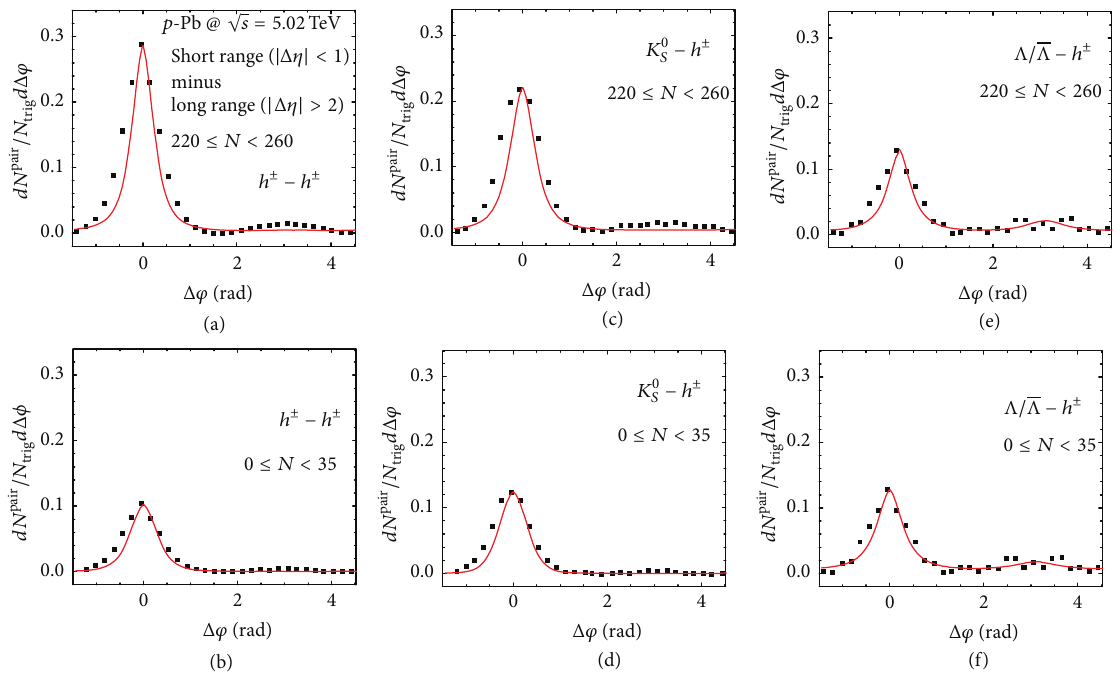
Figure 5: Dihadron azimuthal correlations for the short-range region ( |Δ𝜂| < 1) minus long-range region ( |Δ𝜂| > 2) in p -Pb collisions at √𝑠 = 5 . 02 TeV in the multiplicity ranges 220 ≤ 𝑁 < 260 (a, c, e) and 0 < 𝑁 < 35 (b, d, f). Both 𝑝 trig NN b), (c, d), and (e, f) of the figure correspond to ℎ ± − ℎ ± , 𝐾 0 𝑆 − ℎ ± , and Λ/Λ − ℎ ± correlations, respectively. The symbols denote the data of the CMS Collaboration at the LHC [16], and the lines denote the modeling